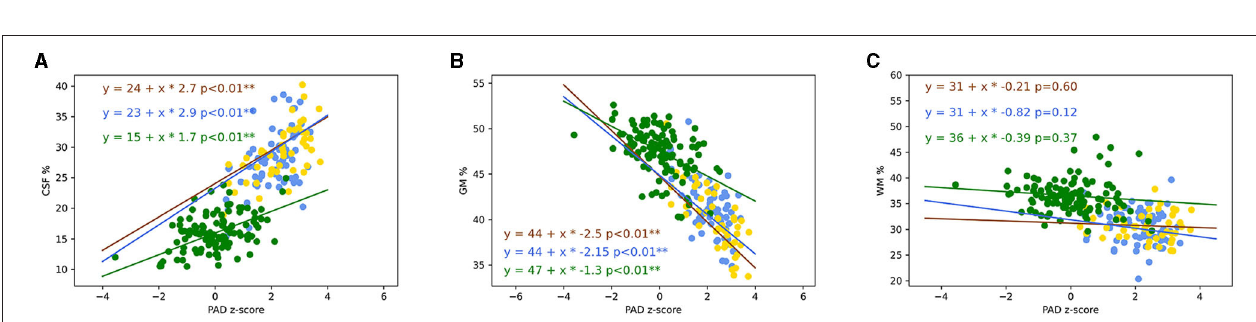
FIGURE 7 | Plot of the percentage of brain CSF (A) , GM (B) , and WM (C) volumes in function of PAD. Lines represented trajectories using linear regression model (blue line: amnestic EOAD; yellow line: non-amnestic EOAD; and green line: control). Pearson correlation was computed between PAD and MMSE on non-amnestic and amnestic EOAD populations. The two coefficients of the regression were not statistically different between non-amnestic and amnestic compared to GM and CSF volumes (Chow test). The two coefficients of the regression for PAD in function of GM and CSF volumes were statistically different between controls and EOAD subtypes (Chow test). ** p < 0.05. CSF, cerebrospinal fluid; PAD, predicted age difference; GM, gray matter; WM, white matter; EOAD, early-onset Alzheimer’s disease; MMSE, Mini-Mental State